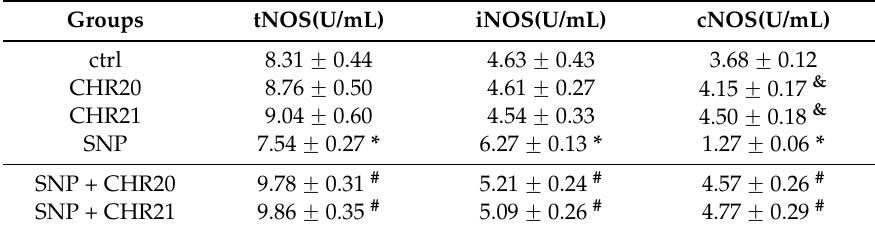
Table 1. The effects of SNP and CHR21 on the activities of tNOS, iNOS, and cNOS a .